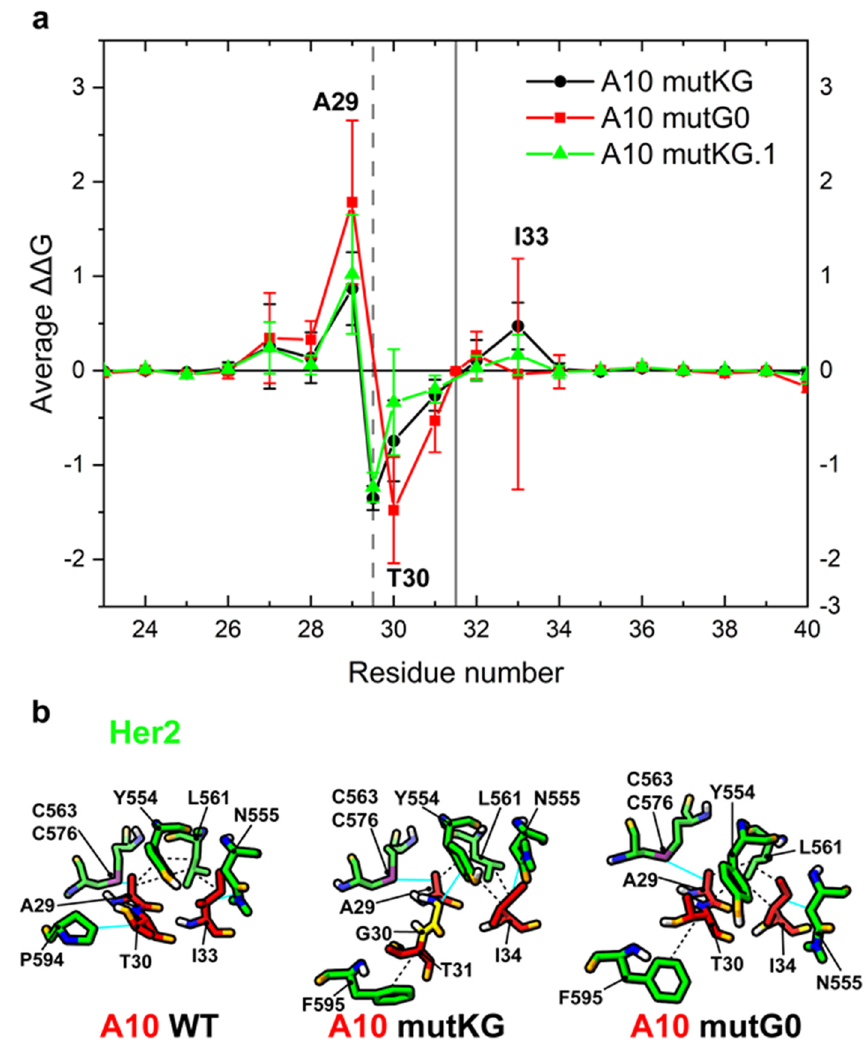
Figure 3. Prediction of per-residue ∆∆ G change of A10 variants in the CDR1 region. ( a ) Plot of average and standard deviation of estimated per-residue ΔΔ G change between A10 wt and the corresponding A10 variants. The grey vertical bars represent the position of glycine insertion in mutKG and mutKG.1 (dashed line) or mutG0 (solid line). The residues with positive or negative average ΔΔ G have reduced or increased predicted binding capacity to Her2, respectively. ( b ) 3D interaction diagram: non-covalent interactions active in at least 50% of simulation frames (see Supplementary Table S2 for details). For each variant, the representative structure shown is the cluster centroids obtained by cluster analysis of MD simulations. Relevant side chains are highlighted. Hydrophobic interactions are depicted by black dashed lines, Van der Waals interactions by cyan lines. The glycine insertion in mutKG is colored in yellow. Nitrogen atoms are colored in blue, oxygen atoms are colored in orange, and hydrogen atoms are colored in white.